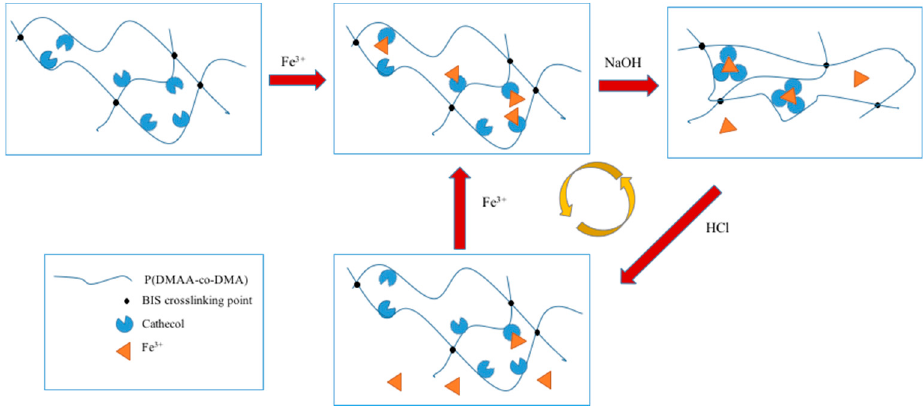
Figure 4. Schematic drawing of reversible complexation of DMA with Fe 3+ ions. Adapted and re-drawn from [38] with permission.